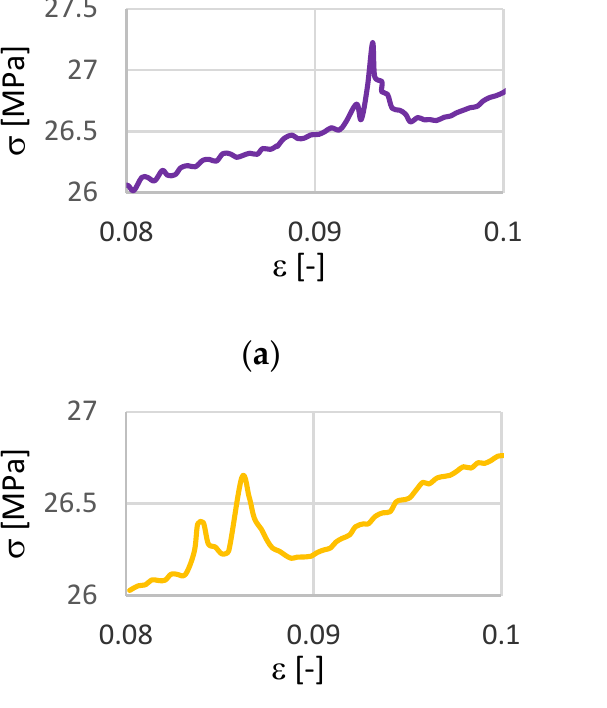
Figure 8. Details from Figure 7: ( a ) for sample 2; ( b ) for sample 3; ( c ) for sample 4; ( d ) for sample 5. For the horizontally layered samples, the tests were performed similarly, resulting in a jagged curve (Figure 9) denoting the breakage in layer binding. The dotted line repre- sents the tangent to the stress-strain curves in the elastic domain.